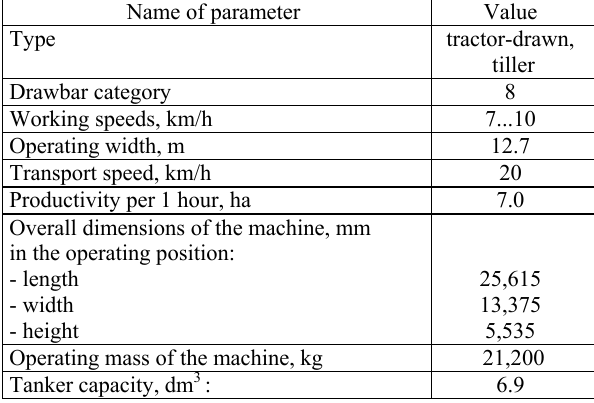
Table 2. Specifications of the PK-12.7 sowing